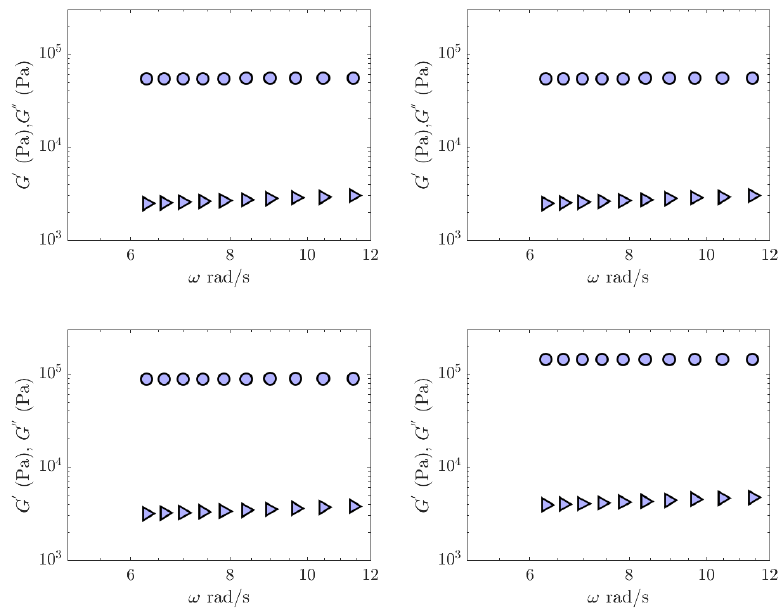
Figure 4. Measured values of storage (circles) and loss (triangles) moduli. The upper row shows the mechanical properties of covers 1 ( left ) and 2 ( right ), and the lower row shows the mechanical properties of covers 3 ( left ) and 4 ( right ). The data were measured by Sree et al. [34].